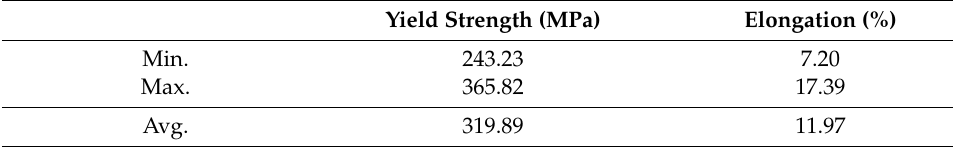
Table 4. Minimum, maximum, and average values of mechanical properties.